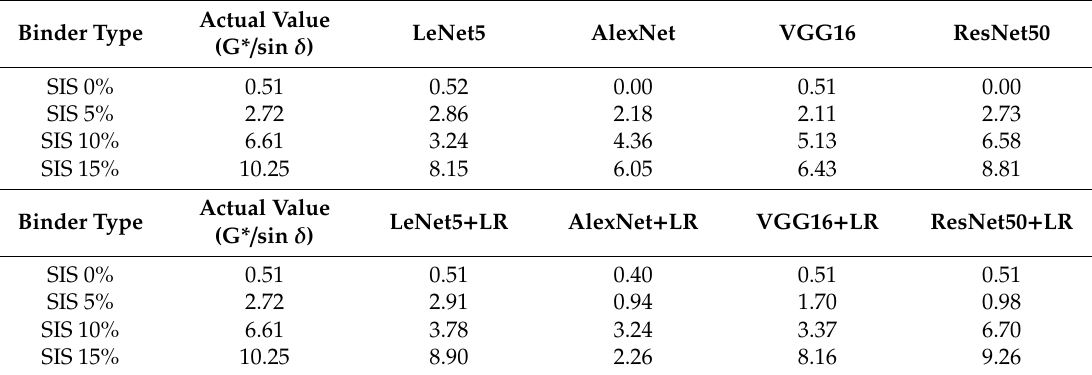
Table 2. Prediction results by eight applied architectures.